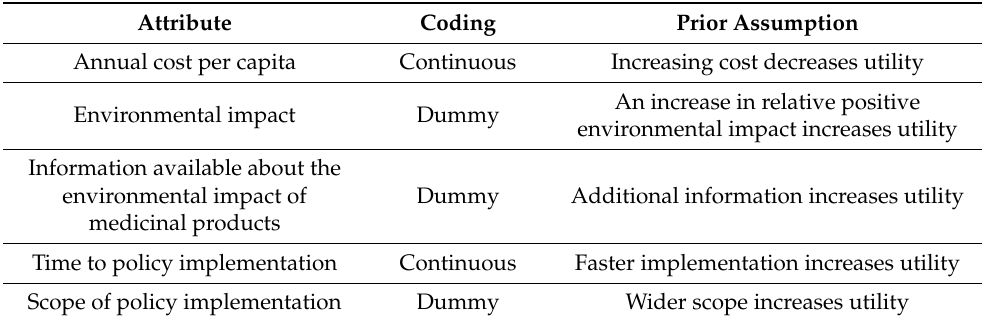
Table 2. Coding of attributes. Attribute Coding Prior Assumption Annual cost per capita Continuous Increasing cost decreases utility An increase in relative positive Environmental impact Dummy environmental impact increases utility Information available about the environmental impact of Dummy Additional information increases utility medicinal products Time to policy implementation Continuous Faster implementation increases utility Scope of policy implementation